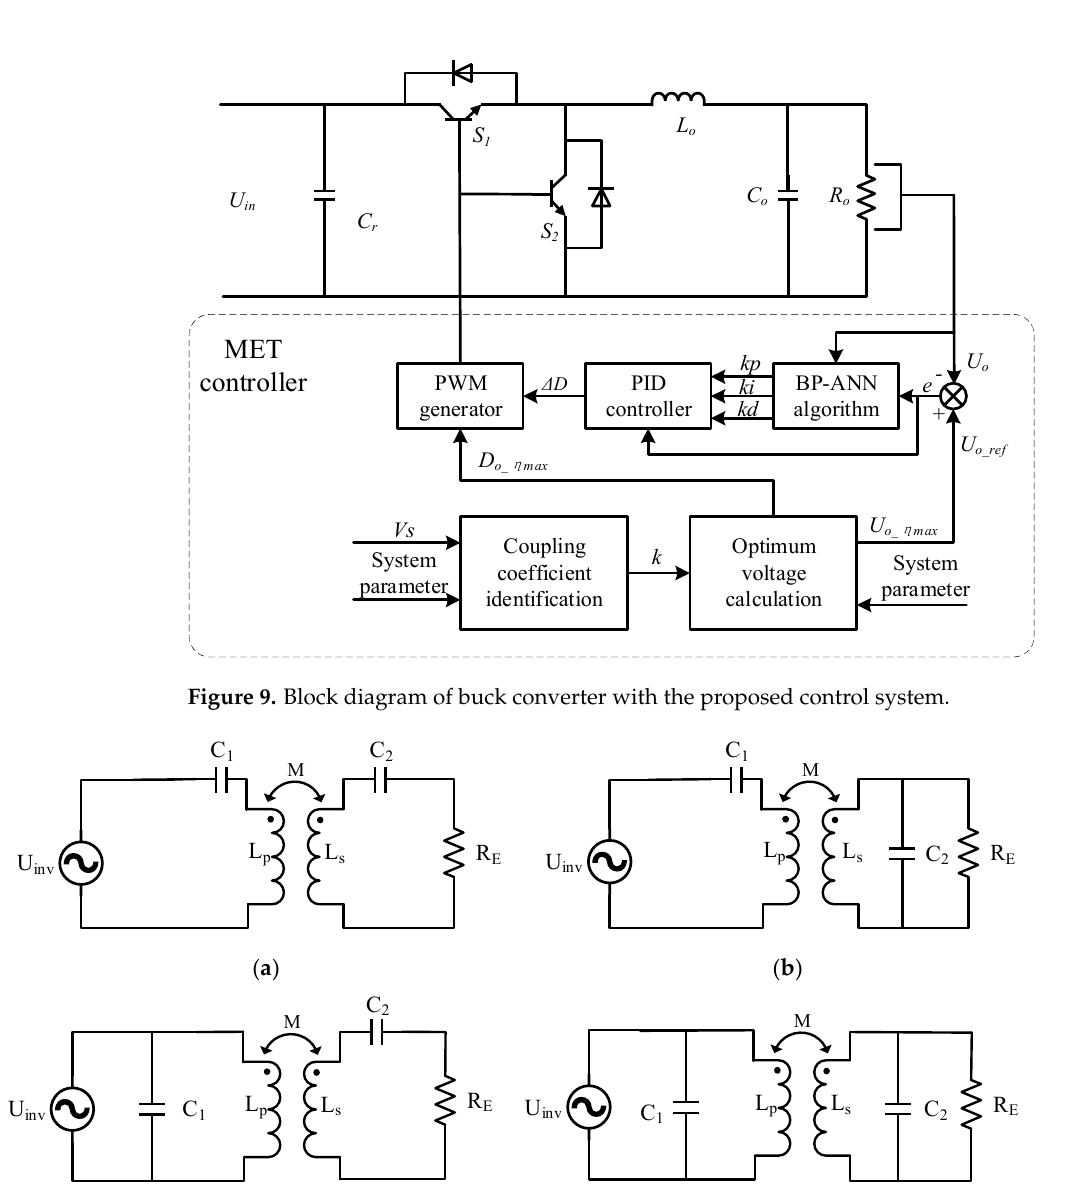
Figure 10. Basic LC compensation topologies. ( a ) S-S Compensation structure; ( b ) S-P Compensation structure; ( c ) P-S Compensation structure; ( d ) P-P Compensation structure.